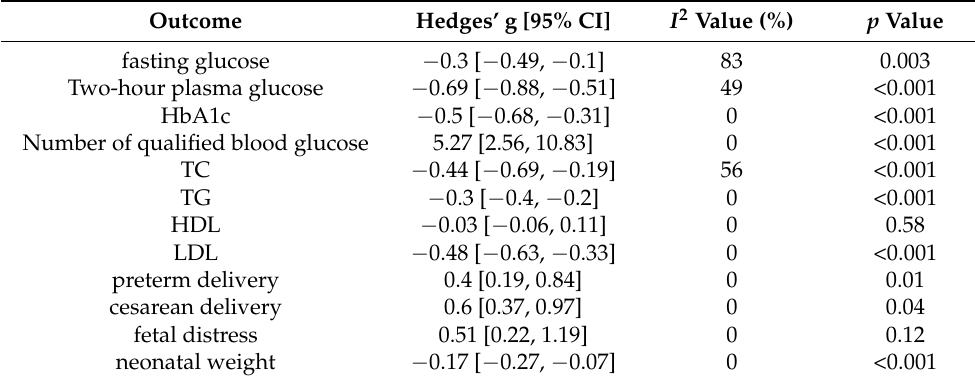
Table 2. Effect sizes and confidence intervals for each outcome.